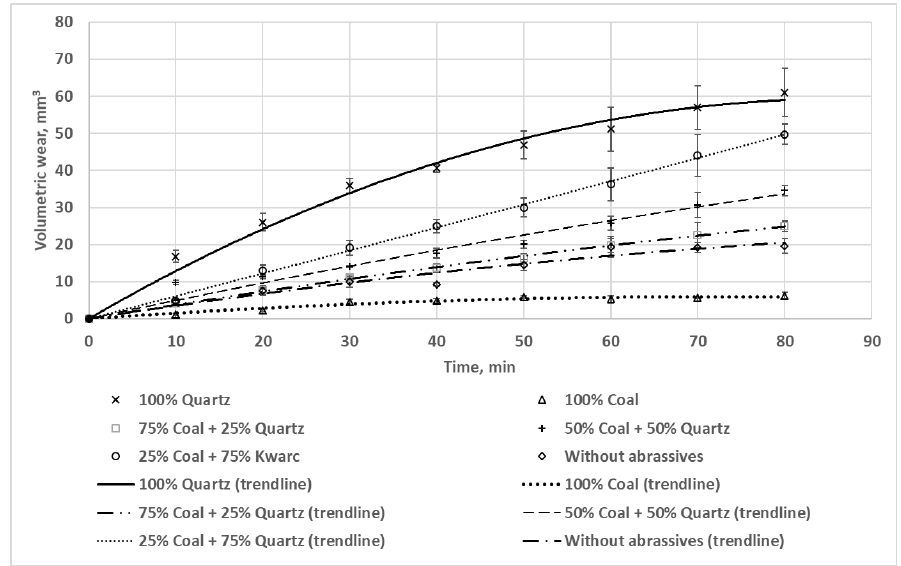
Figure 14. Time processes of volumetric wear u V of WRS_400_I steel for the discussed wear variants.